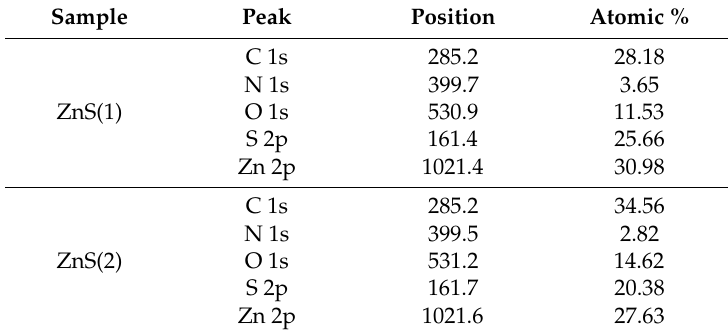
Table 1. Elemental analysis based on X-ray photoelectron spectroscopy (XPS) data for samples ZnS(1) and ZnS(2).